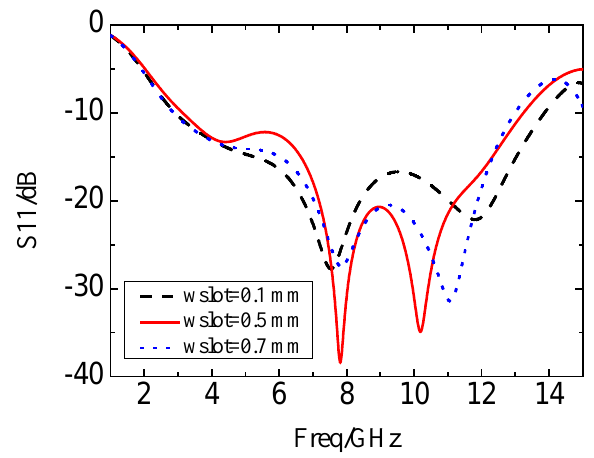
Figure 10. Simulation results of the reflection coefficient with different w slot .